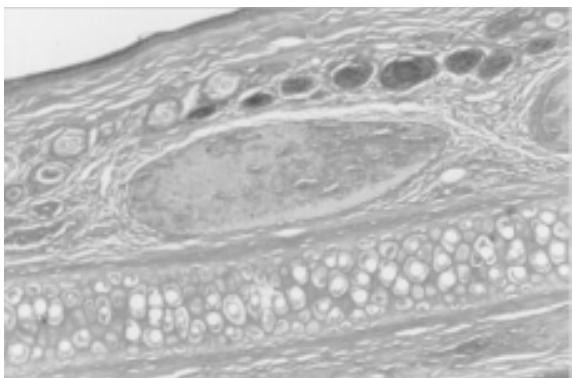
FIGURA 2 - Fotomicrografia mostrando trombo venoso organizado e aderido (cid:224) parede vascular.